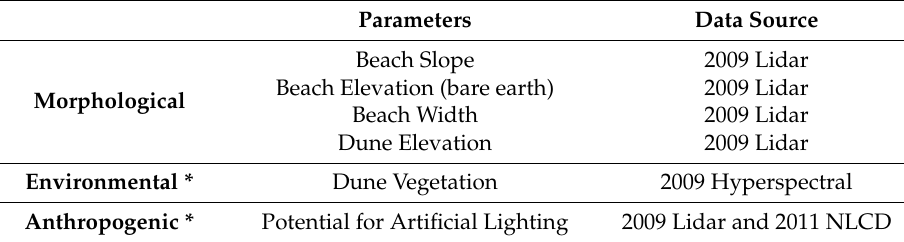
Table 1. List of spatial parameters and datasets and the data